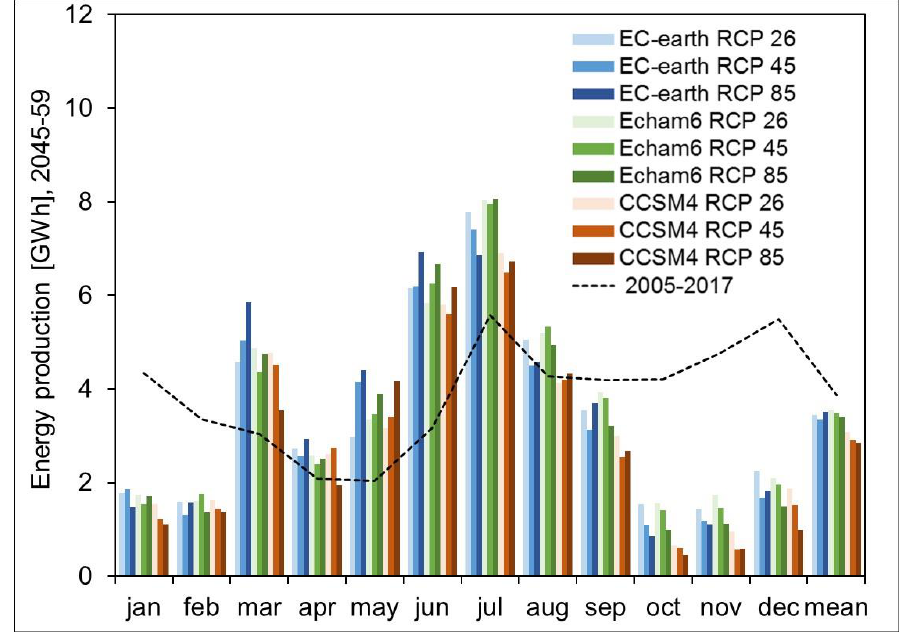
Figure 5. Sabbione reservoir. Estimated mean monthly energy production E p . Control Run (2005–2017), and projected. Period P1 (2045–2059).